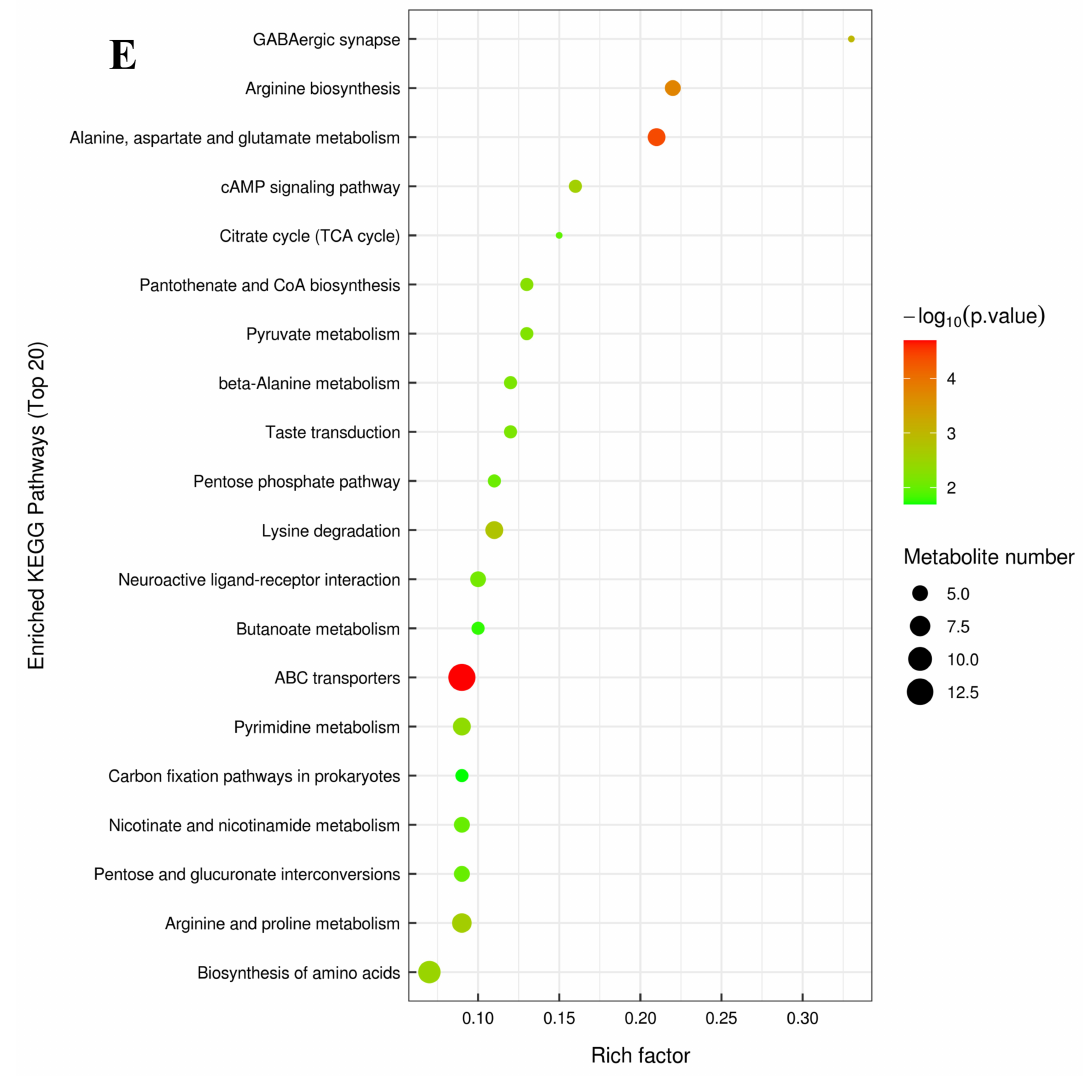
Figure 6. Untargeted metabolome profile of P. italicum treated with 2 − CDs. Volcano plot of DAMs (differentially accumulated metabolites) in positive ion mode ( A ) and negative ion mode ( B ). Hierarchical cluster heat map of DAMs in positive ion mode ( C ) and negative ion mode ( D ) (i: D − C, i2: D − 2 − CDs). ( E ) Top 20 pathways encompassed by DAMs (VIP > 1, p value < 0.05). The rich factor represents the proportion of DAMs in the pathway among the metabolites detected. Color represents p -value; red color: low p -value, green color: high p -value; circle size corresponds to gene number.